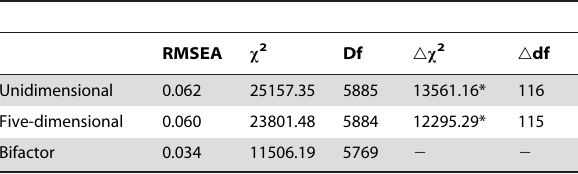
Table 3. Model comparison between unidimensional, five- dimensional and bifactor